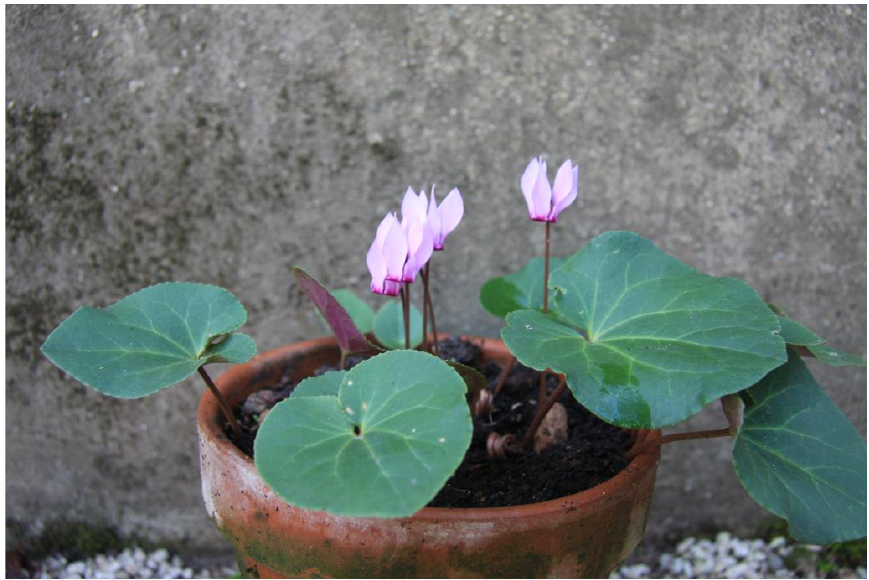
Figure 14. C. purpurascens ‘Podsreda’.